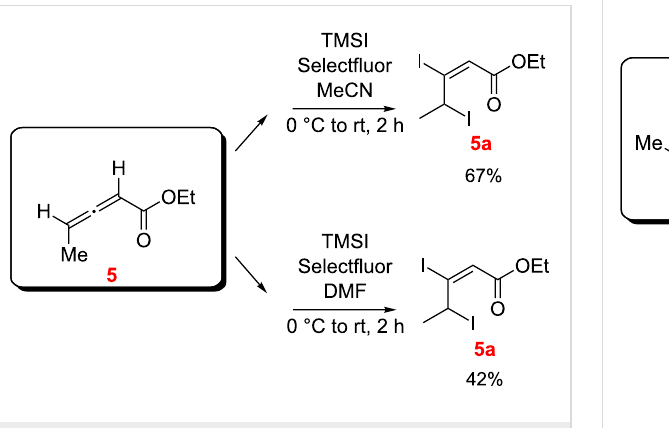
ucts 4a , 4b (in a 1:1 ratio by NMR; this fraction also contained traces of unreacted 4 ). With TMSCl/Selectfluor and NH 4 SCN/ Selectfluor only the corresponding regioisomeric conjugate ad- dition products 4d , 4e and 4f , 4g were isolated. The diiodoalkenoate 5a was obtained in good isolated yield from the reaction of ethyl allenoate 5 with TMSI/Selectfluor in DMF and in MeCN and the conjugate addition products were not observed (Scheme 8).